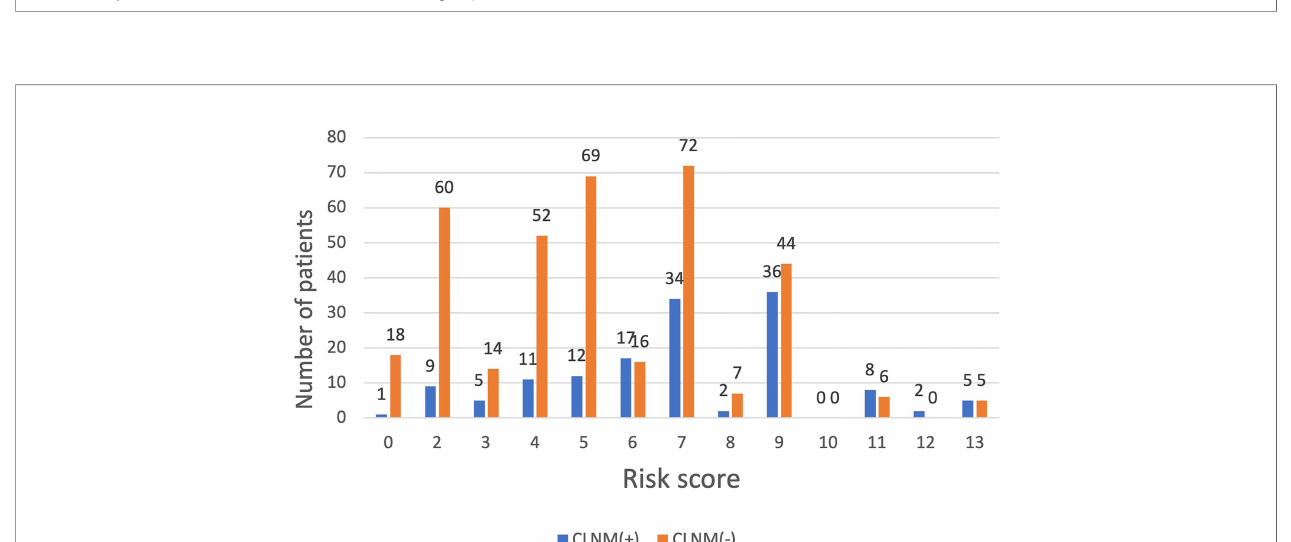
FIGURE 2 | ROC curve of risk factor scores in model group.